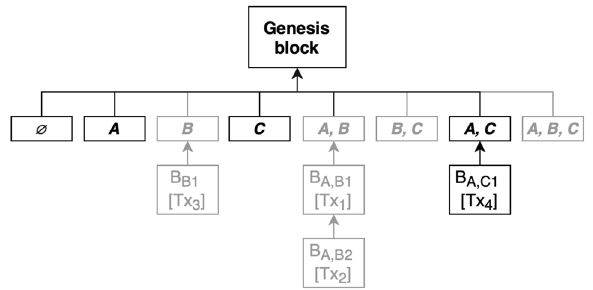
Figure 2. Leave of a participant implies deleting all of their shared subchains marked in this example with a gray